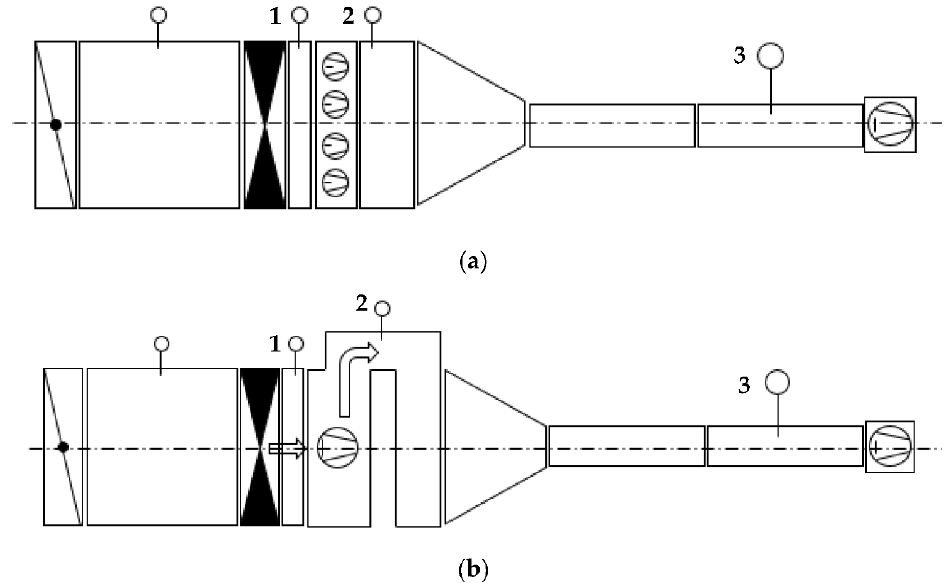
Figure 8. Schematic representation of the test-rig with flap, evaporator, and support fan used for the assessment of the electrical power consumption and sound power level of axial ( a ) and radial ( b ) fans. (1) Measurement point of pressure difference on the under-pressure side of the fans, controlled by means of ventilation flap, (2) measurement point of pressure difference on the overpressure side of the fans, controlled by means of a support fan, (3) measurement point of air volume flow through a hot wire anemometer.